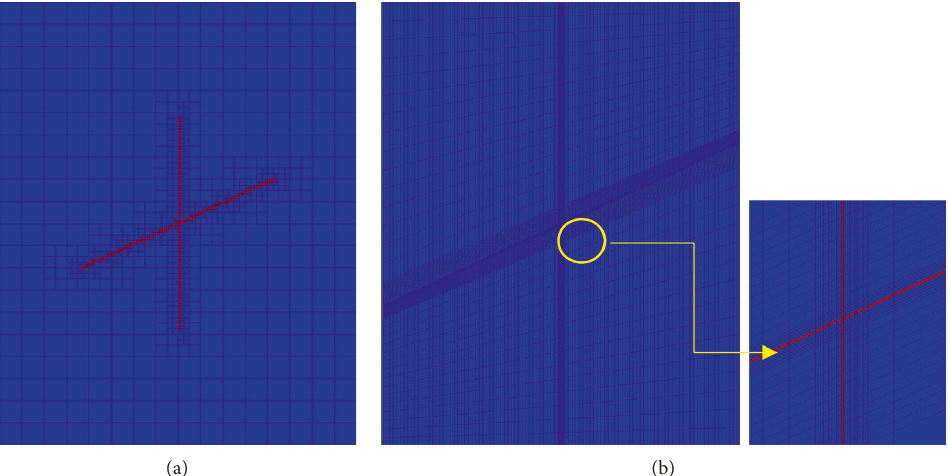
Figure 11: Hydromechanical simulation of the fractured medium with two fractures: case of the nonuniform mesh model using the local refinement technique ( h � 7.81mm) (a); case of the conformed mesh model (b).